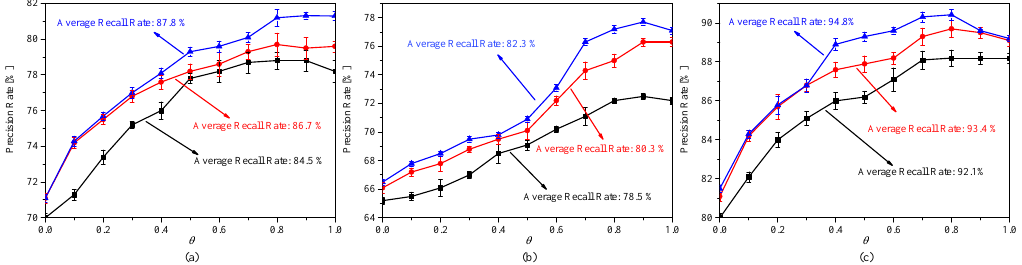
Figure 9. Validation results by using different kinds of samples to detect the multiple pedestrian crossing with different strategies of step-size. ( a ) The variable of precision ratio and recall ratio with the fixed-step π /4 by using zero and one samples to predict the detection of two pedestrian crossing. ( b ) The variable of precision ratio and recall ratio with the fixed-step π /10 by using zero and one samples to predict the detection of three pedestrian crossing. ( c ) The variable of precision ratio and recall ratio with the adaptive variable-step by using zero, one and two samples to predict the detection of three pedestrian crossing. Note that the blue, red and black lines are denoted the adaptive variable-step, fixed-step π /4 and fixed-step π /10 respectively.